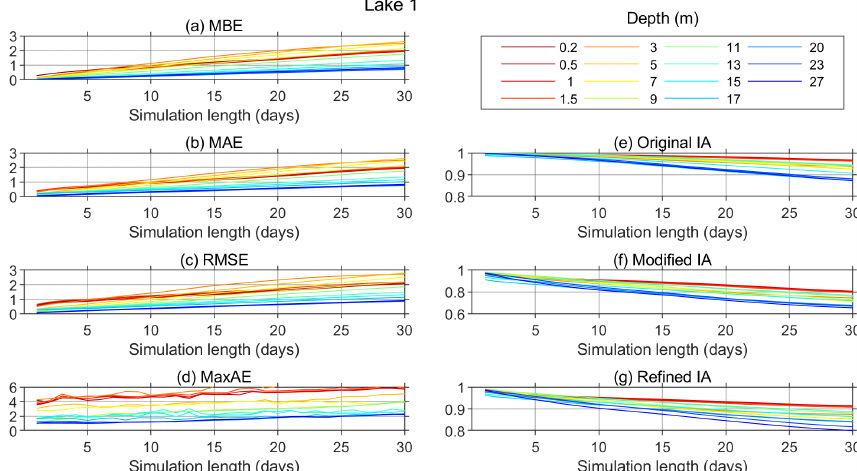
Figure 9. Model performance parameters for Lake 1 (calculated for all the periods with necessary data available: 6 July–31 December 2019 and 2 July–30 September